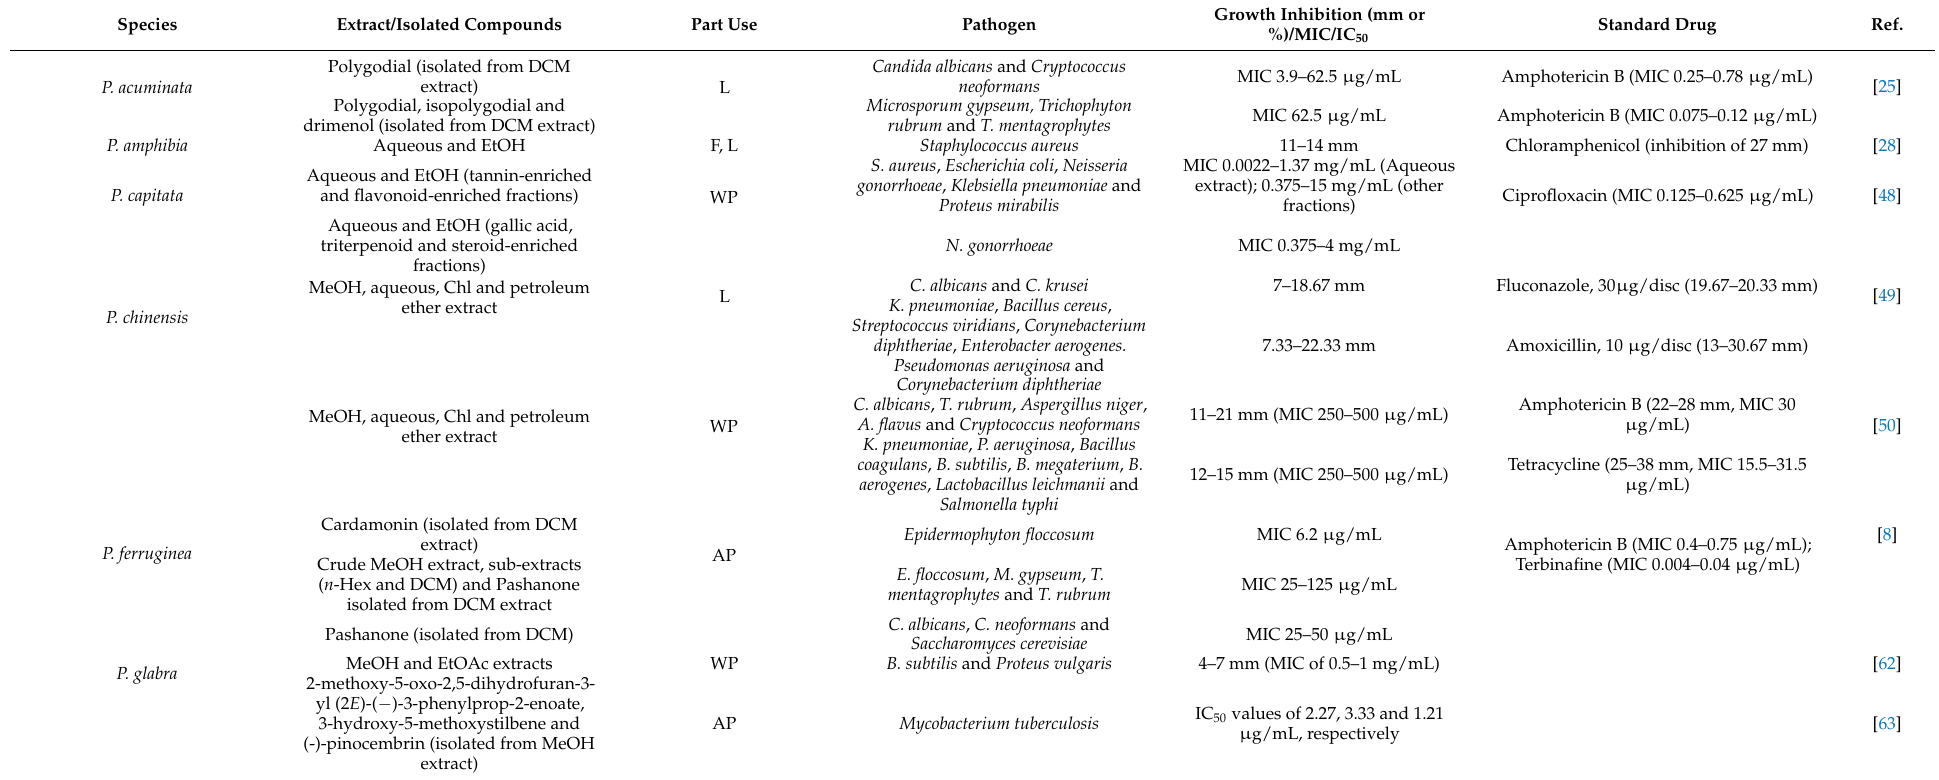
Table 2. Antimicrobial activity of Persicaria and Polygonum species against human fungal and bacterial pathogens. Extracts, compounds, part of plant used, antimicrobial activity, standard drug and references are shown. Extracts: DCM (dichloromethane); EtOH (ethanol); MeOH (methanol); Chl (chloroform); Hex (hexane); EtOAc (ethyl acetate); But (butanol). Part used: L (leaves); F (flowers); R (roots); Sp (sprouts); S (seeds); St (stems); WP (whole plant); AP (aerial